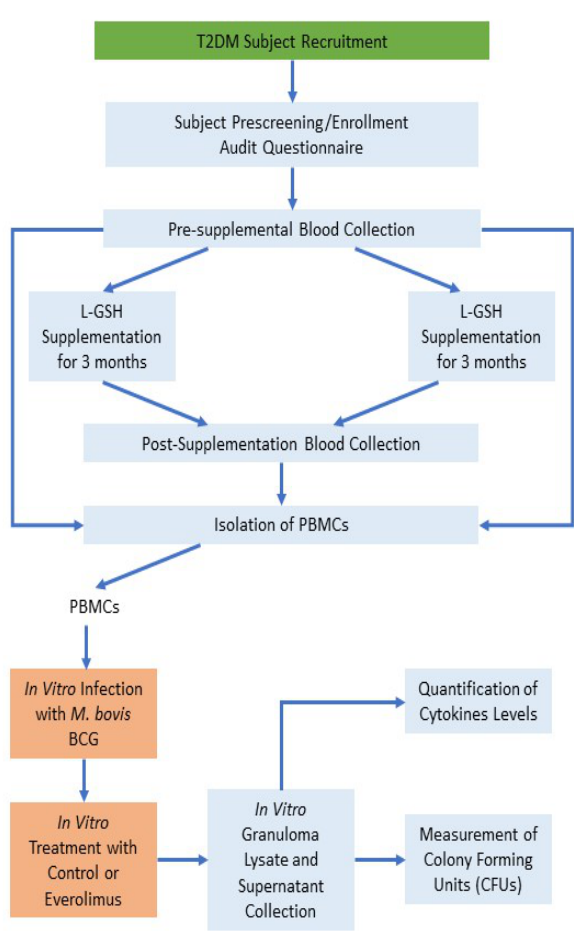
Figure 1: Schematic representation of the overall study design.